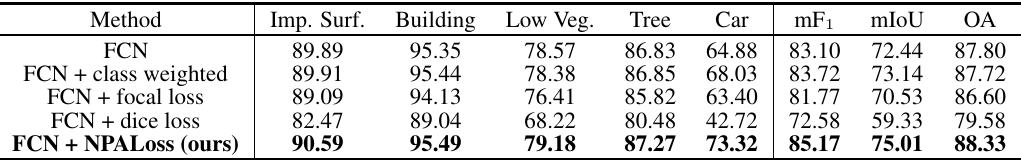
Table 1. The performance of FCN with different loss functions.